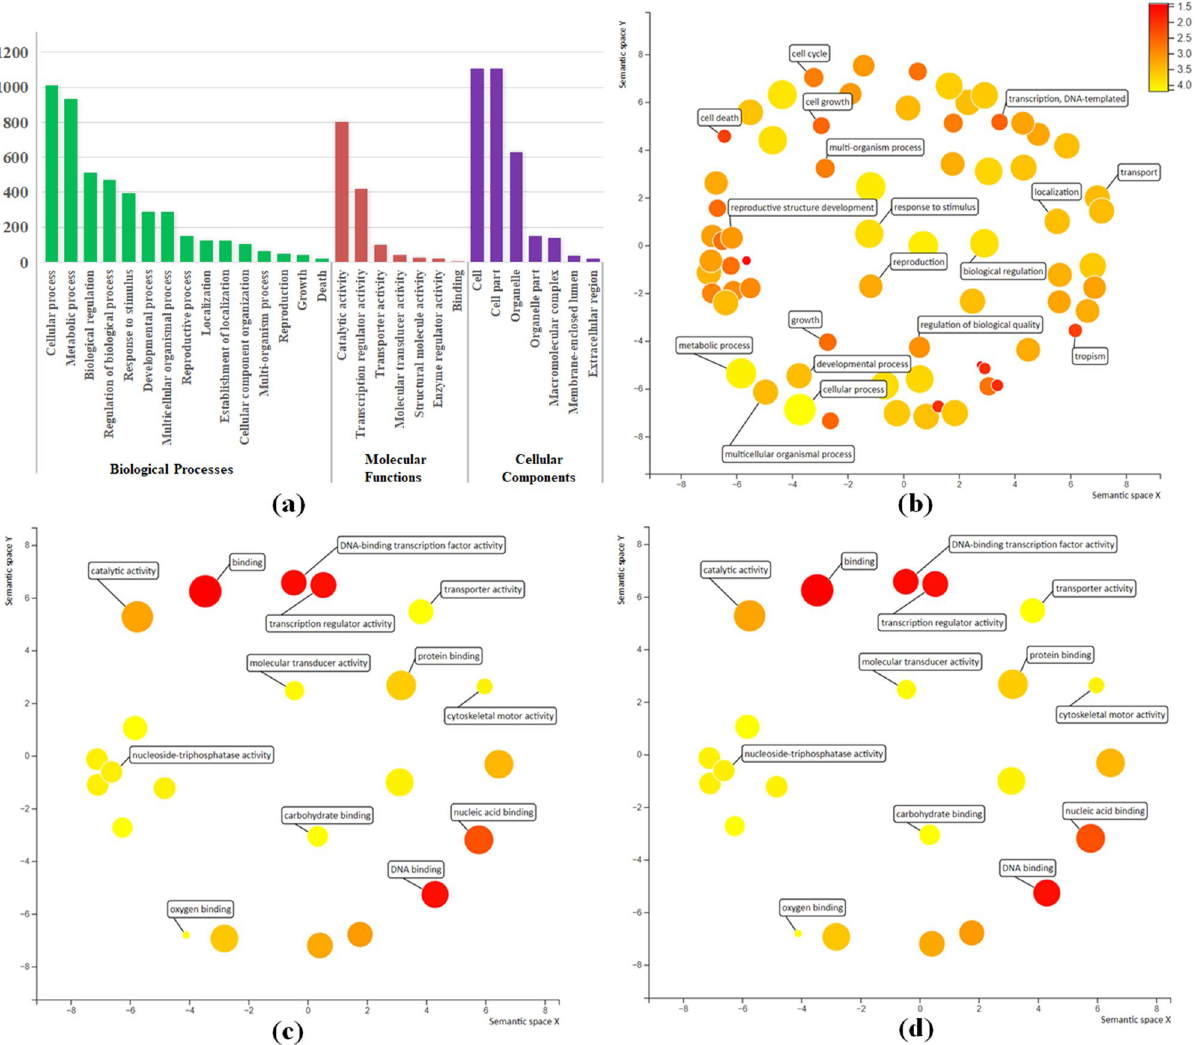
Figure 3. Gene Ontology (GO) analysis: ( a ) GO annotation of transcripts harbouring SSR loci’s classified into Biological Process, Cellular Component and Molecular Functions; ( b ) GO enrichment analysis representing Biological Process; ( c ) Cellular Component; ( d ) Molecular Functions. Gene Region